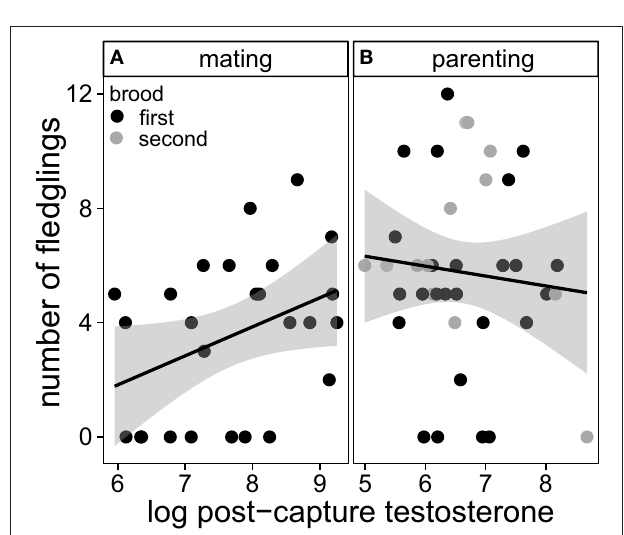
FIGURE 2 | Total annual number of fledglings in relation to circulating testosterone concentrations of males caught during the mating (A) and the parental phase (B). Black points refer to males caught and sampled for testosterone during their first brood; gray points refer to males caught during their second brood. Lines and shaded areas represent regression estimates and their 95% credible intervals. The 95% credible interval of the regression slope during mating does not include zero; thus males with higher levels of testosterone produced more fledglings than males with lower levels of